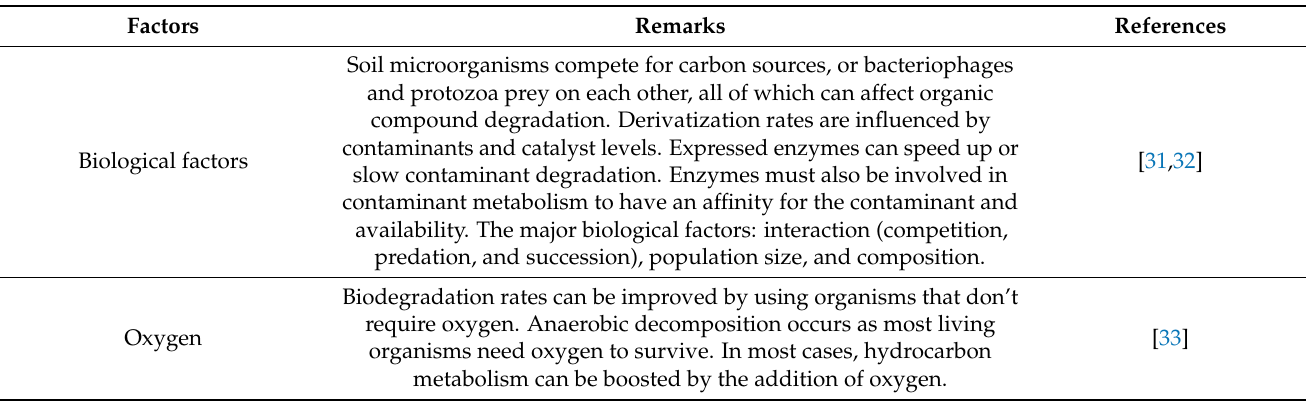
Table 1. Critical factors for microbial